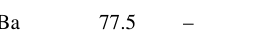
Table 2 Elemental composition of weighting agents using XRF